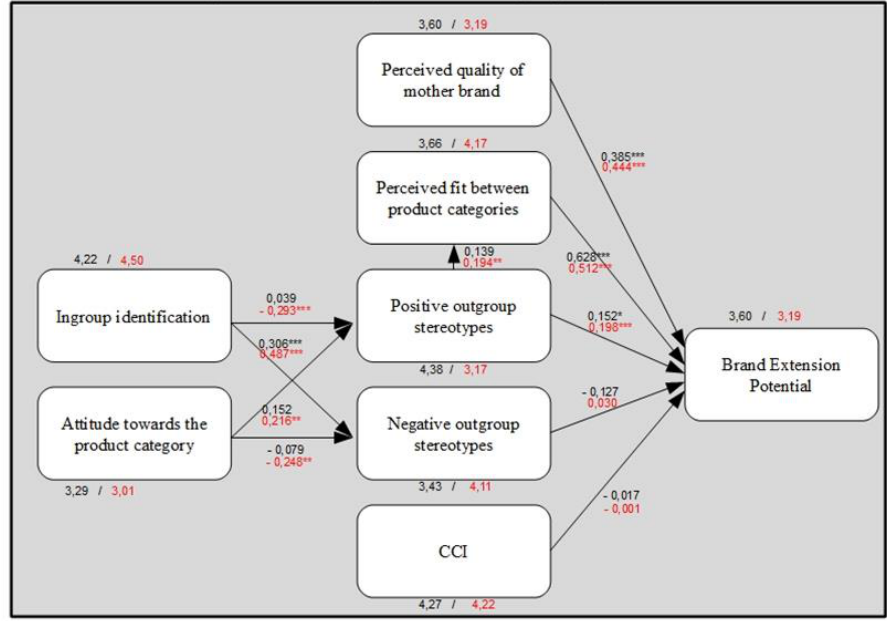
Fig. 3. Multiple group